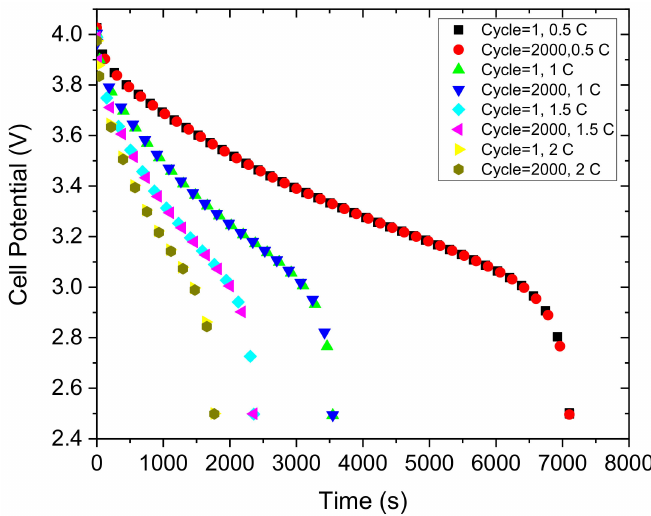
Figure 9. Simulated Comparisons of the discharge curves after 2000 cycles at four rates of discharge (0.5C, 1C, 1.5C,2C) for NMC cathodes. The relative capacity under a load 1C remained unchanged at 0.85 after 2000 cycles for NCA cathode, while it was unchanged at 0.98 for